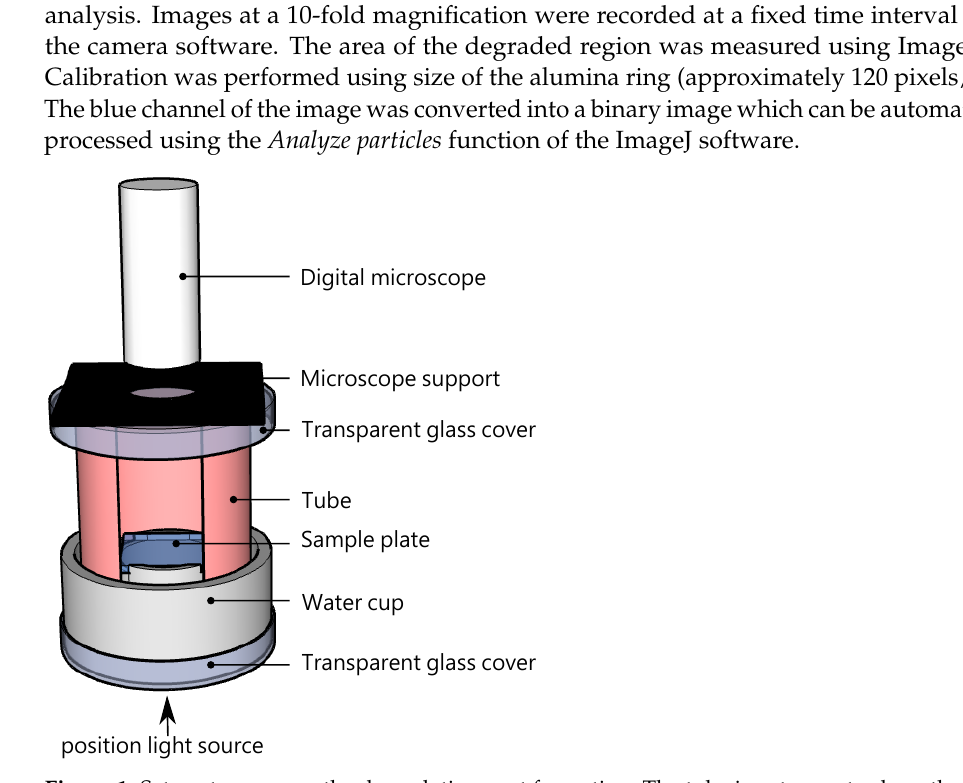
Figure 1. Set-up to measure the degradation spot formation. The tube is cut open to show the set-up interior and the sample holder. The light source (not shown) is cooled with a ventilator (not shown) to avoid heating and water